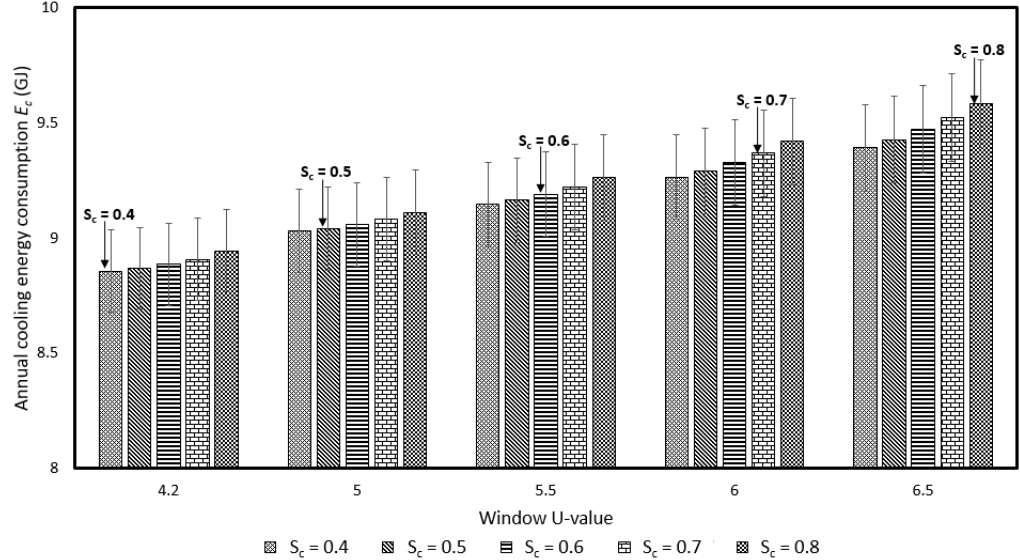
Figure 7. Annual cooling energy consumption with variation in window U-value (W/(K · m 2 )) and shading coefficient S c .